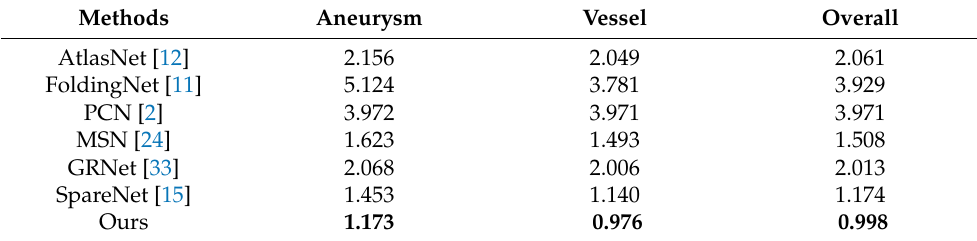
Table 2. Point completion results on IntrACompletion in CD × 10 3 (lower is better).